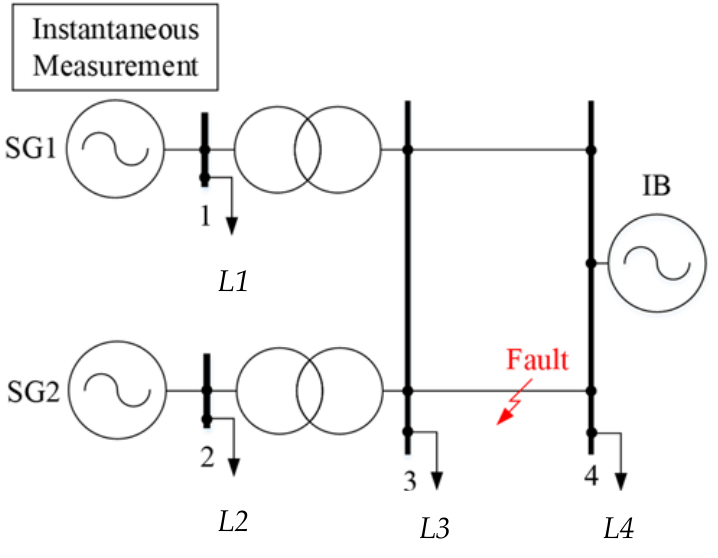
Figure 7. The power system model.